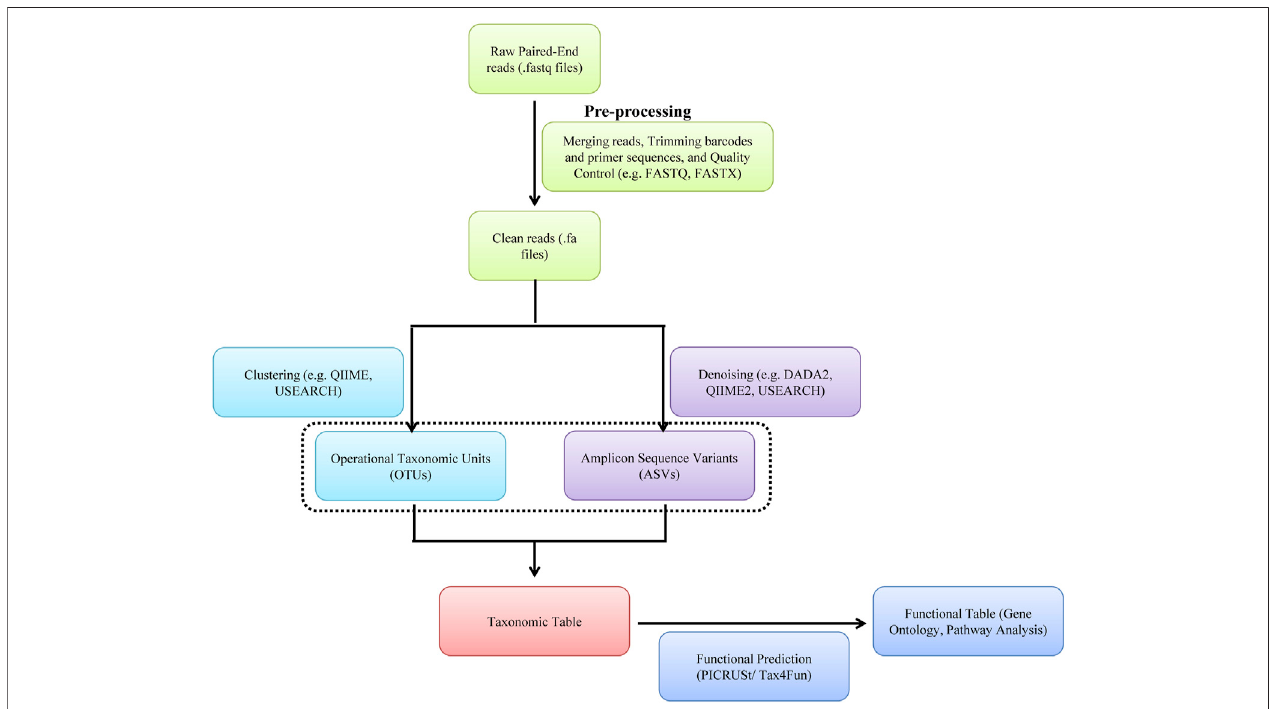
FIGURE 5 | A software pipeline for analysis of amplicon sequencing of bacteria. Each type of experiment has distinct requirements and challenges but there is a common work fl ow/pipeline.